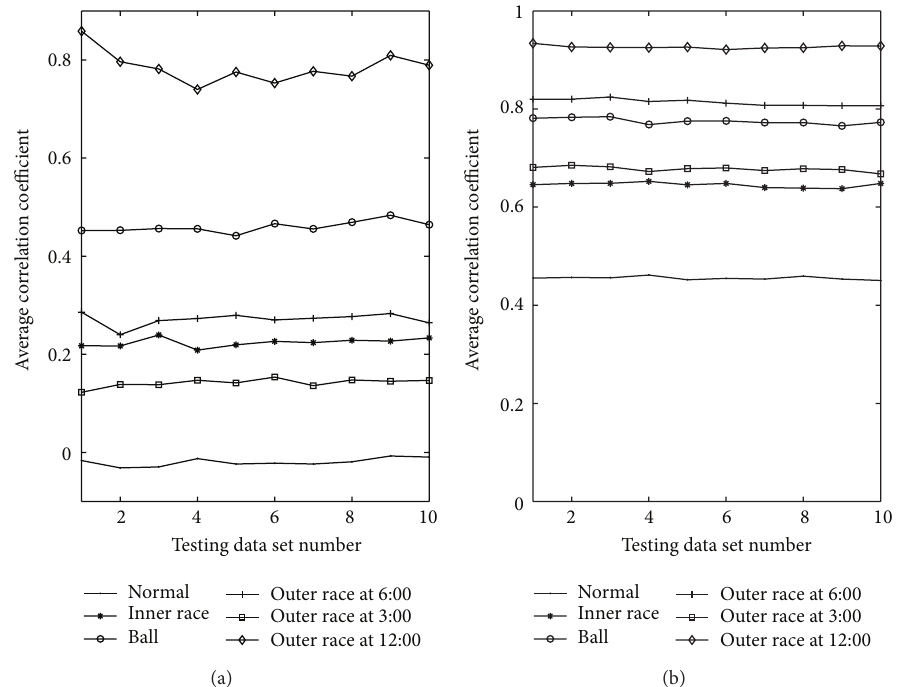
Figure 9: Detection results of data set A with an outer fault located at 12:00 according to morphology spectrum correlation analysis: (a) signal based triangular SE; (b) flat